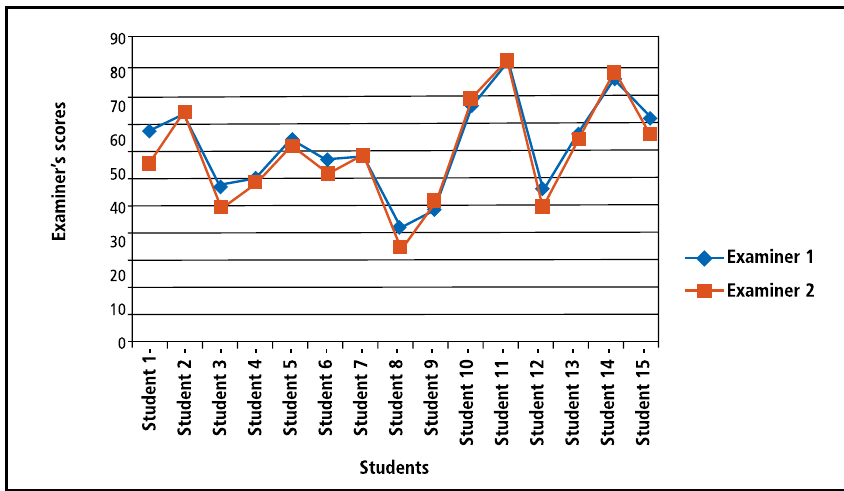
figure 2: examiner assessment